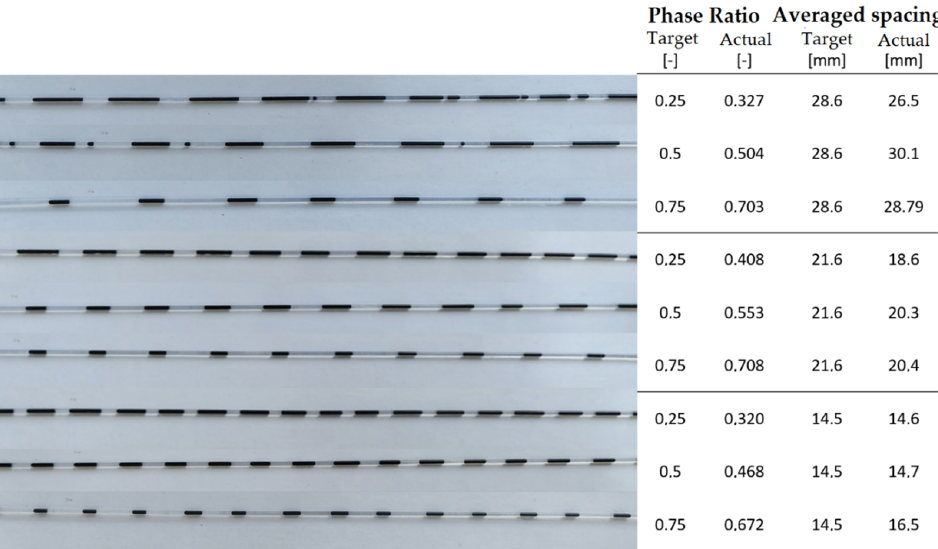
Figure 10. Flow conditions at different phase ratios with values of the phase ratios and the averaged distances .